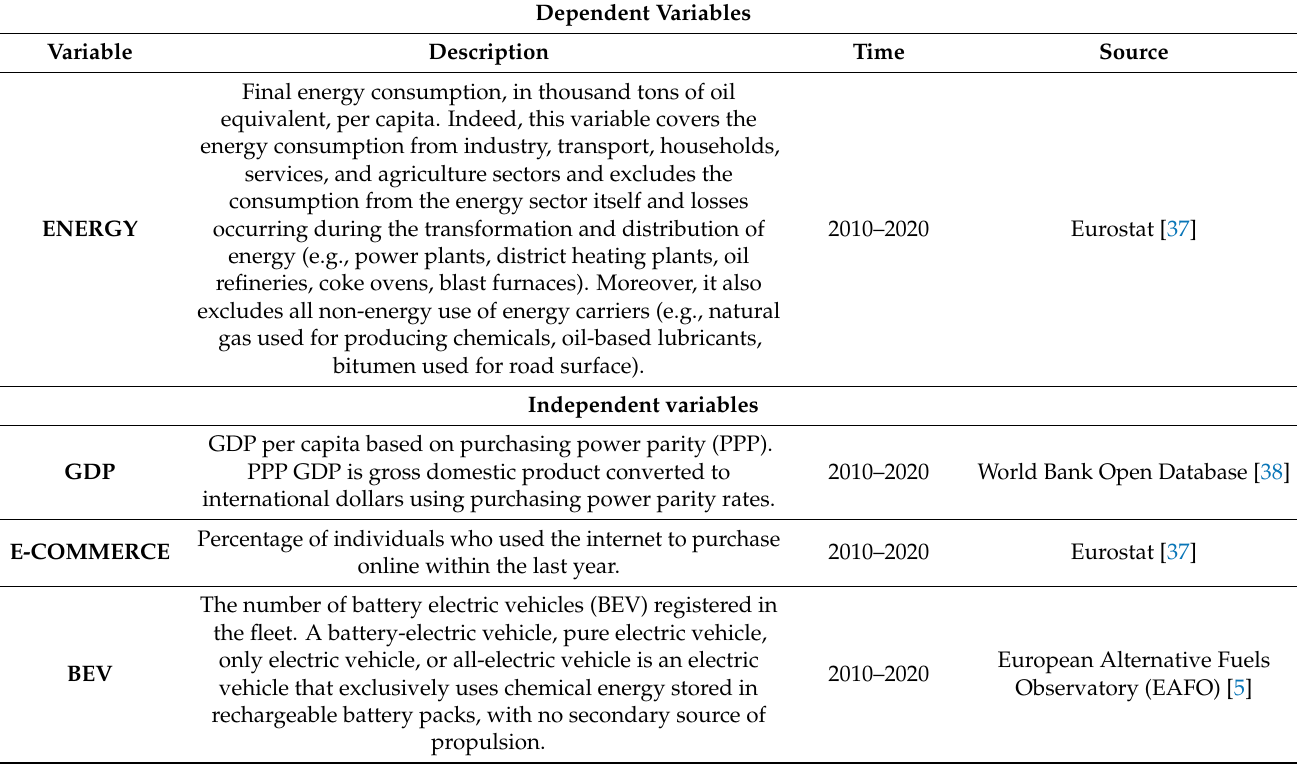
Table 1. Variables’